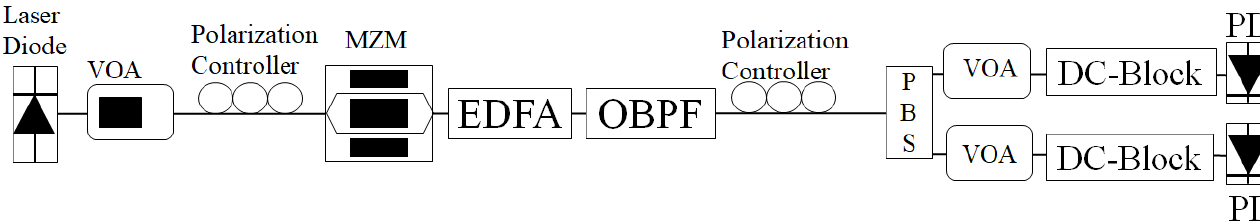
Figure 6. Experimental scheme.